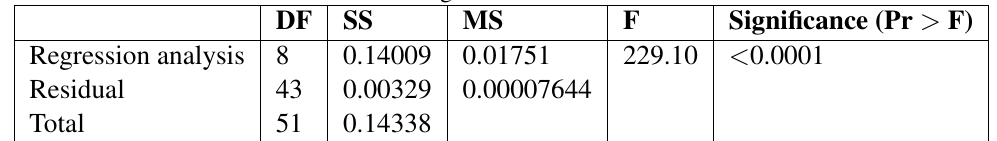
Table 2 Regression statistics